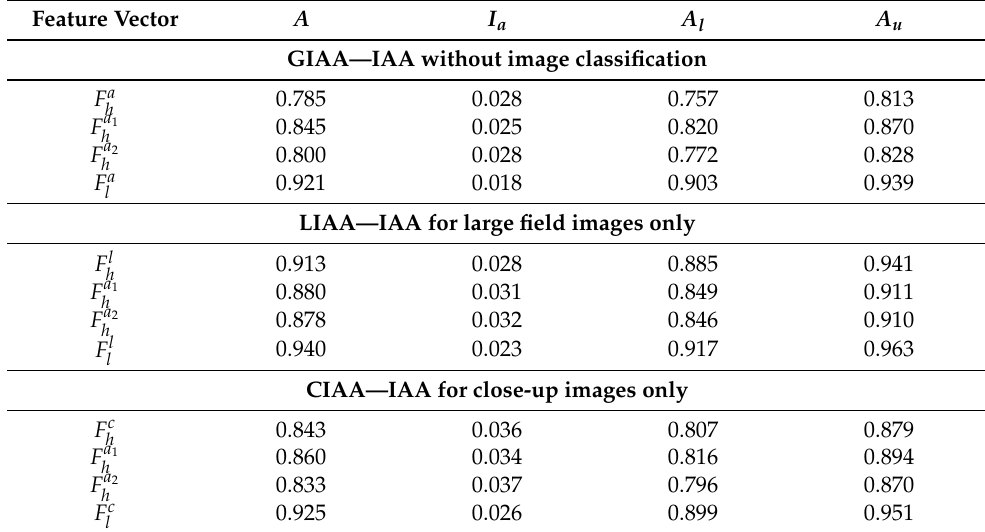
Table 9. Evaluations of IAA with and without image classification using handcrafted and learned fea-